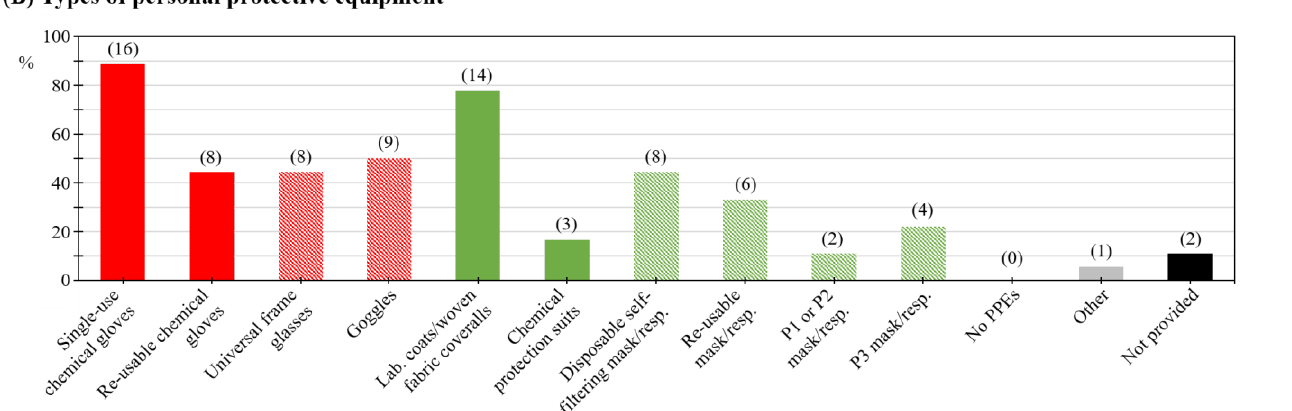
Figure 3. Health and safety (H&S) plan and practice: ( A ) Types of engineering controls. The square box on the right panel ( n = 8) details types of local exhaust ventilation system; ( B ) Types of personal protective equipment (PPE) with numbers of respondent companies indicated in brackets. HEPA: high-efficiency particulate air filtration. ULPA: ultra-low particulate air filtration.